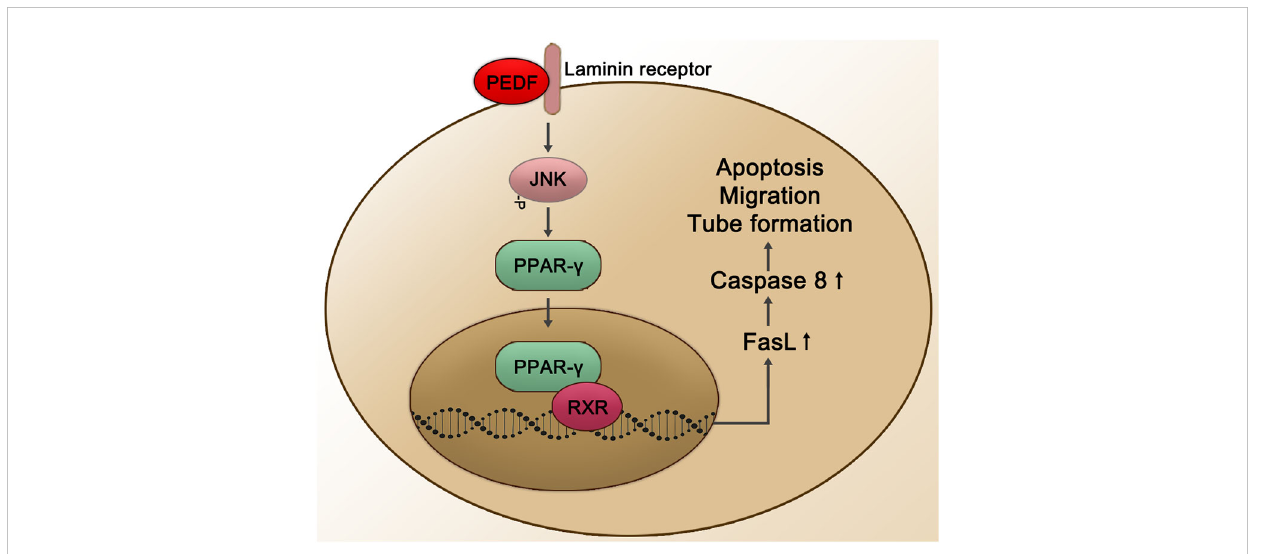
FIGURE 4 Schematic representation of the PEDF-activated laminin receptor. The PEDF 34mer binds to LR to activate the JNK-PPAR- g -dependent signal transduction pathway. Subsequently, the combination of PPAR- g and RXR is activated in the nucleus, promoting the transcription mechanism of FasL gene promoters and affecting biological processes through the upregulation of Caspase 8, such as cell apoptosis, migration, and tube formation. JNK, Jun N-terminal kinase; RXR, retinoid X receptor.